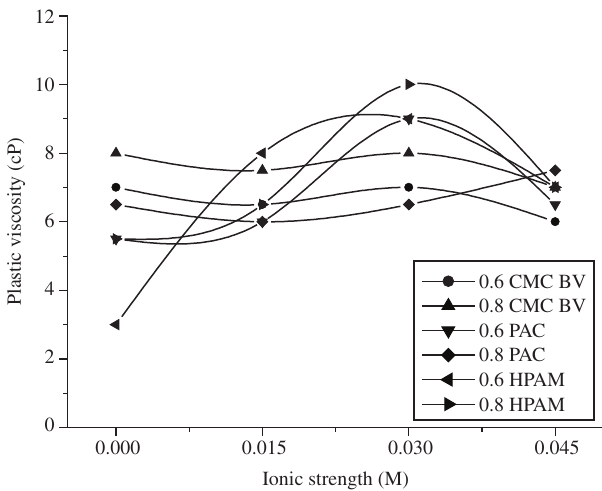
0.000 Figure 2. Influence of ionic strength on the plastic viscosity of bentonite suspensions treated with